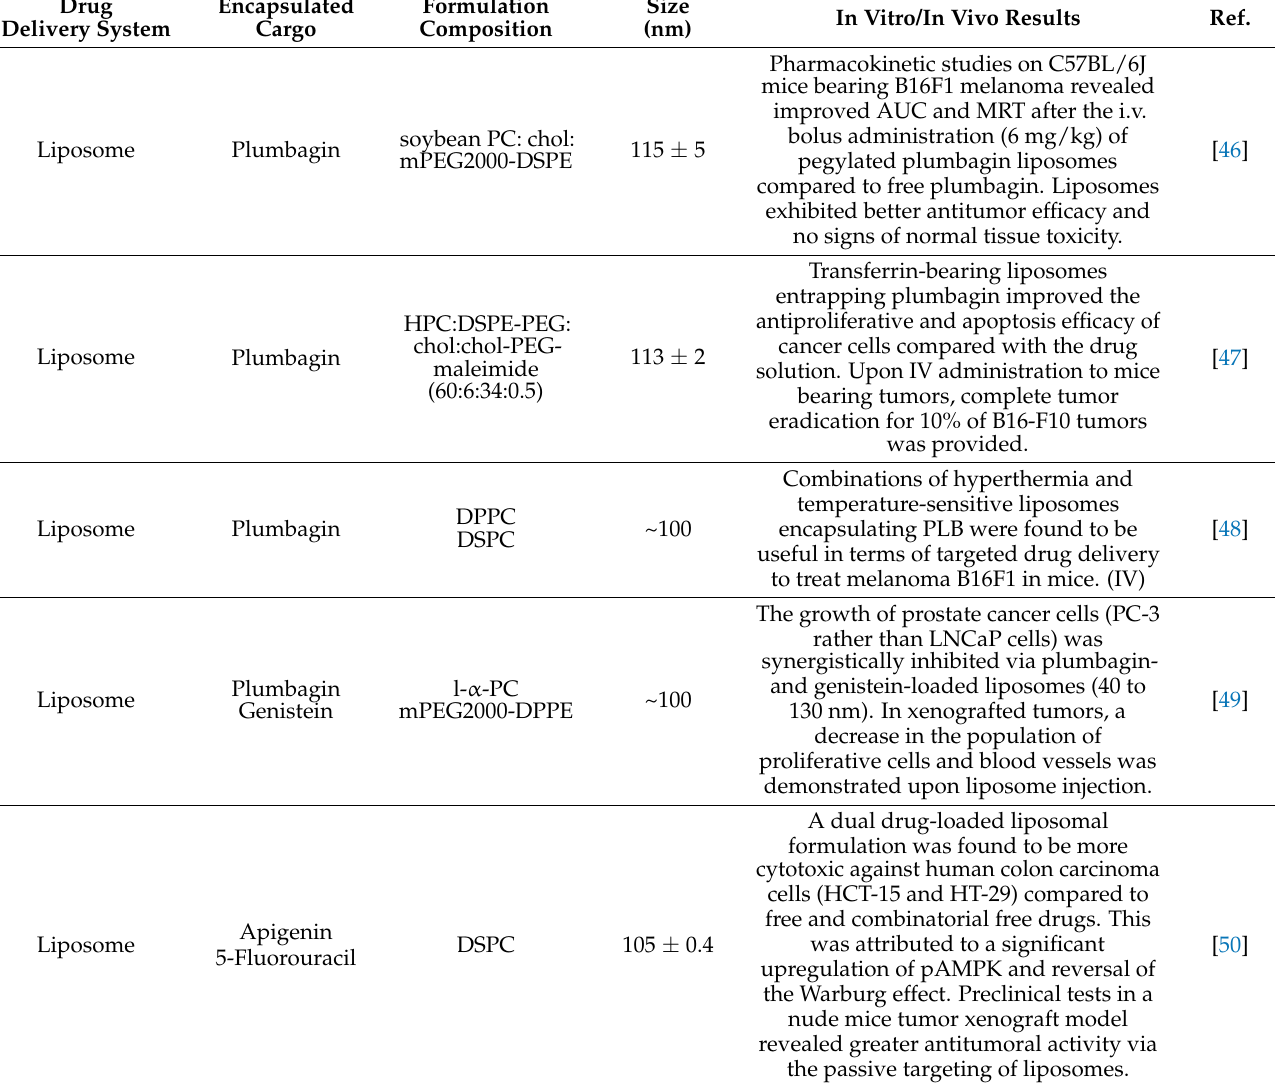
Table 1. Studies addressing NRF2 inhibitor-loaded NDDSs for cancer treatment. Drug Delivery